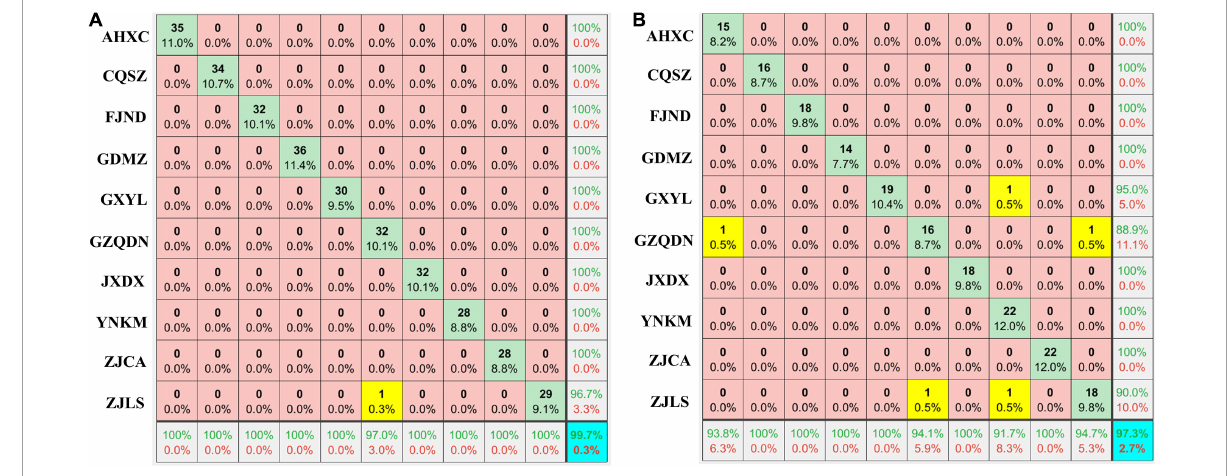
FIGURE2 Geographical origins discrimination for RRB fruits using the DER-PLSDA model based on full wavelengths. Training set (A) , Prediction set (B) . The number in blue color represents the total discrimination accuracy on the training and prediction sets, and the yellow color represents the groups with discrimination errors. The results of sensitivity and specificity are shown in the bottom row and the right column, respectively.